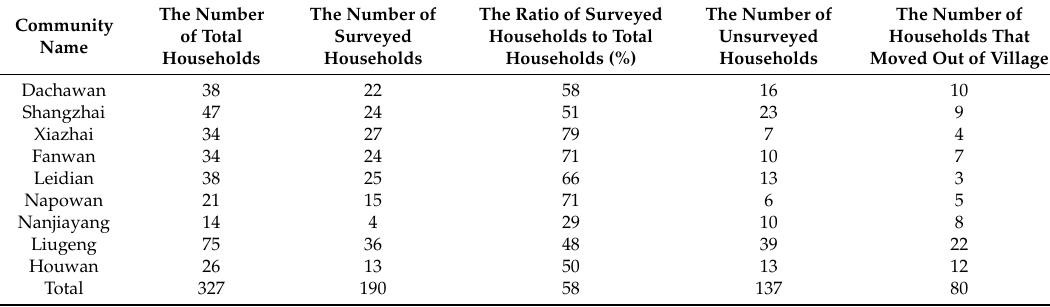
Table 1. Household survey of Sihe